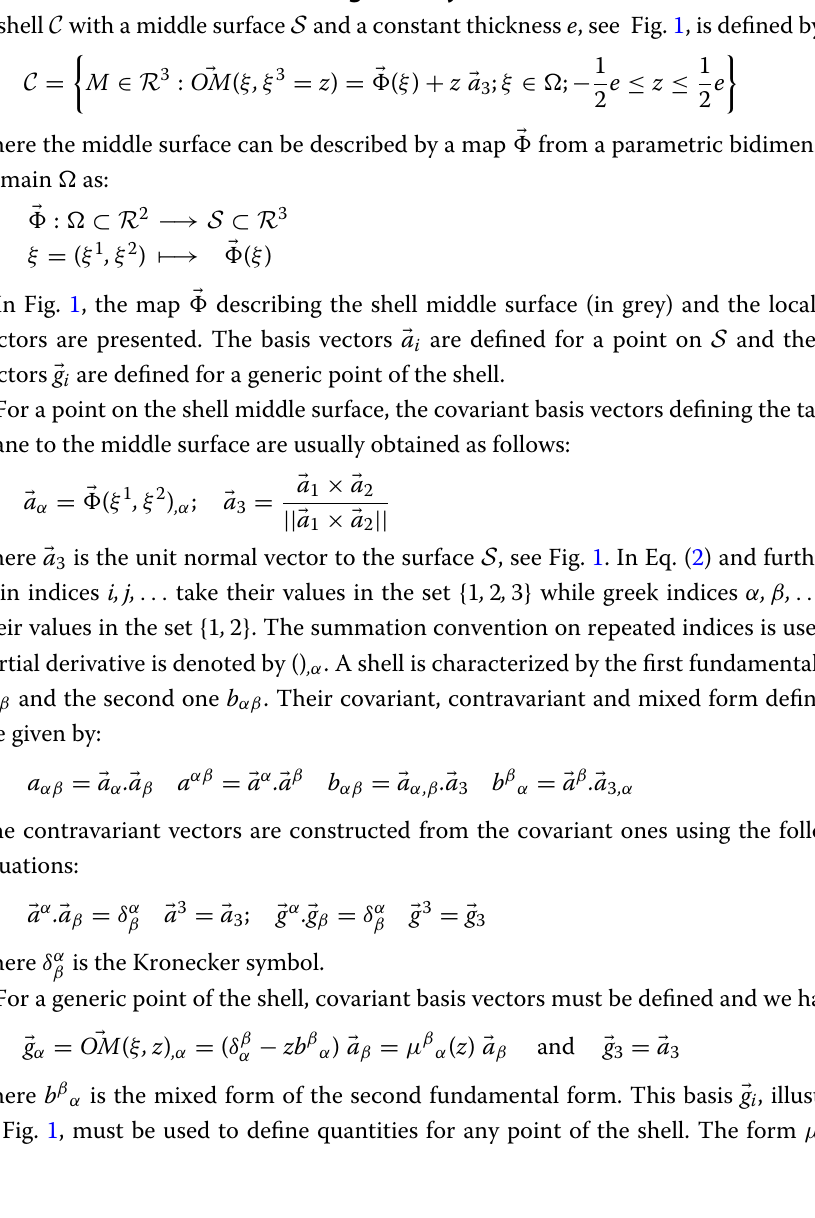
Shell definitions and differential